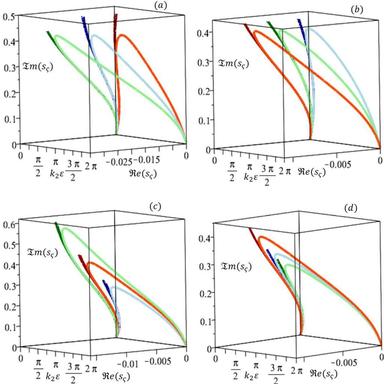
Dispersion functions associated to shear waves travelling along e2. Comparison between the two homogenized models (dark line) and the heterogeneous one (light line); (a) is obtained by setting τ 1 ς = τ 2 ς = 2, η = 1, rρ = rE = 10, ν˜1 = ν˜2 = 0.2 and by varying the dimensionless elastic parameter γ = 1/10 (red curves), γ = 1/5 (blue curves) and γ = 1/2 (green curves); (b) is obtained by setting η = 1, rρ = rE = 10, ν˜1 = ν˜2 = 0.2, γ = 1/10 and by varying the dimensionless relaxation time τ 1 ς = τ 2 ς =